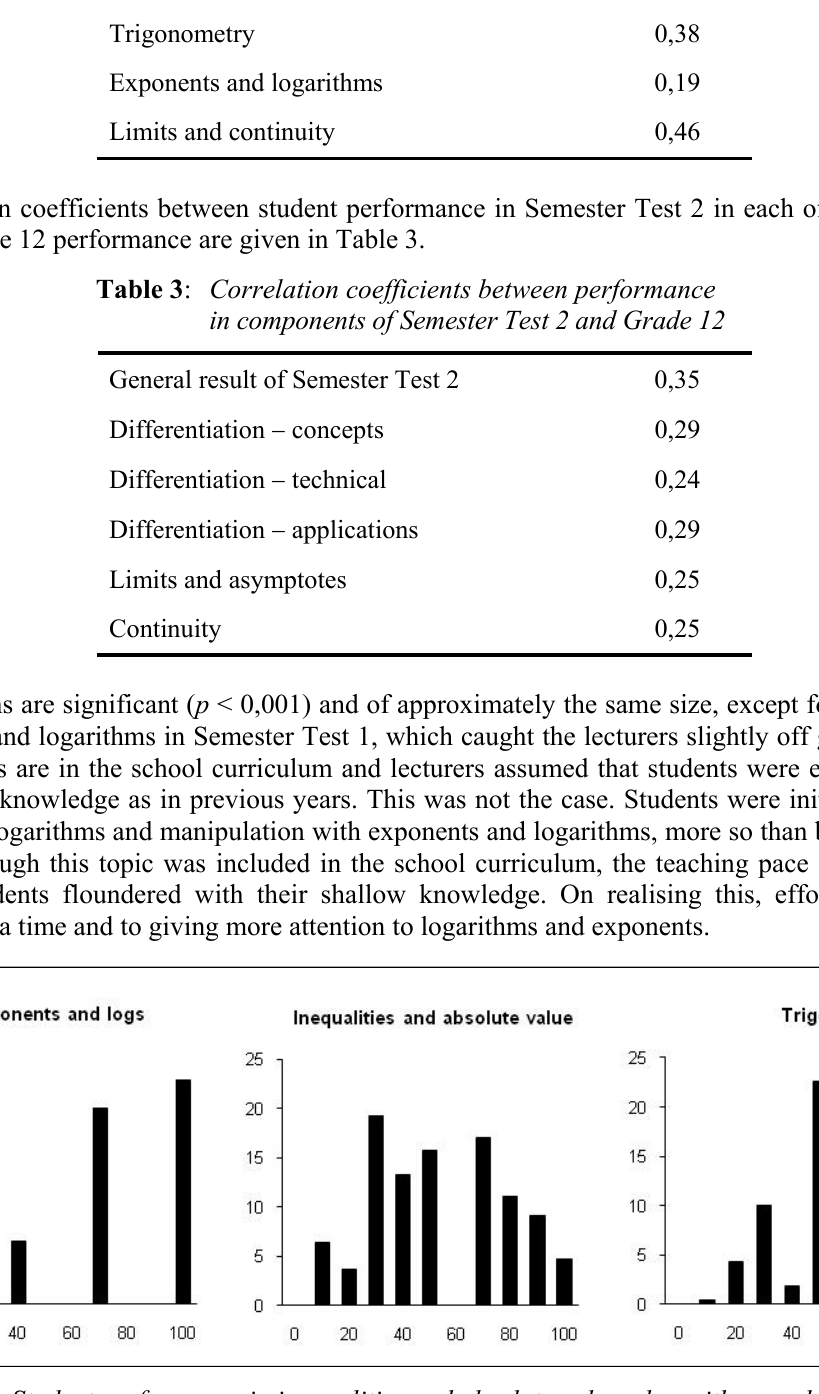
Figure 7 : Student performance in inequalities and absolute values, logarithms and exponents and trigonometry in Semester Test